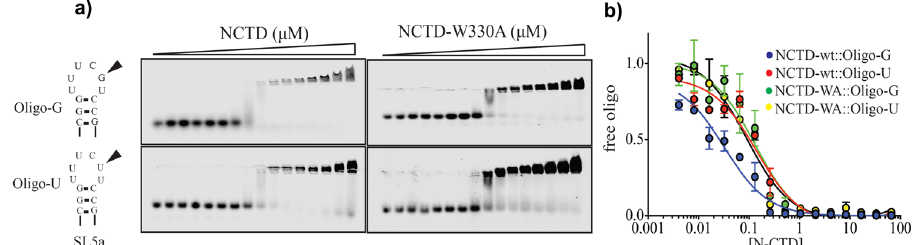
Fig. 4 Binding of NCTD to the apical region of SL5a RNA. a Ag-EMSA gels of titration experiments. Binding of N CTD and N CTD-W330A to an ssRNA oligonucleotide from the apical part of the SL5a region of SARS-CoV-2 gRNA with conserved guanine (arrowhead, Oligo-G) or with a G to U mutation (Oligo-U, lower panels). b ssRNA oligonucleotide shift with increasing concentration of protein. Protein – ssRNA combinations are represented in different colors. Trajectories are fi tted to a sigmoidal one-site binding model. The error bar represents the standard error of the mean of at least four